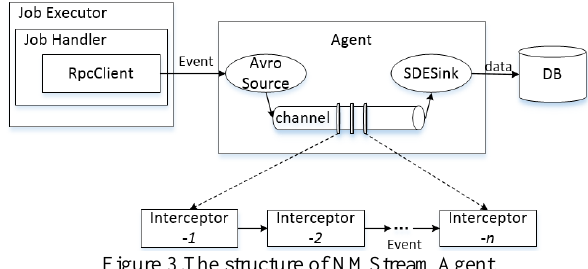
Figure 3.The structure of NMStream Agent